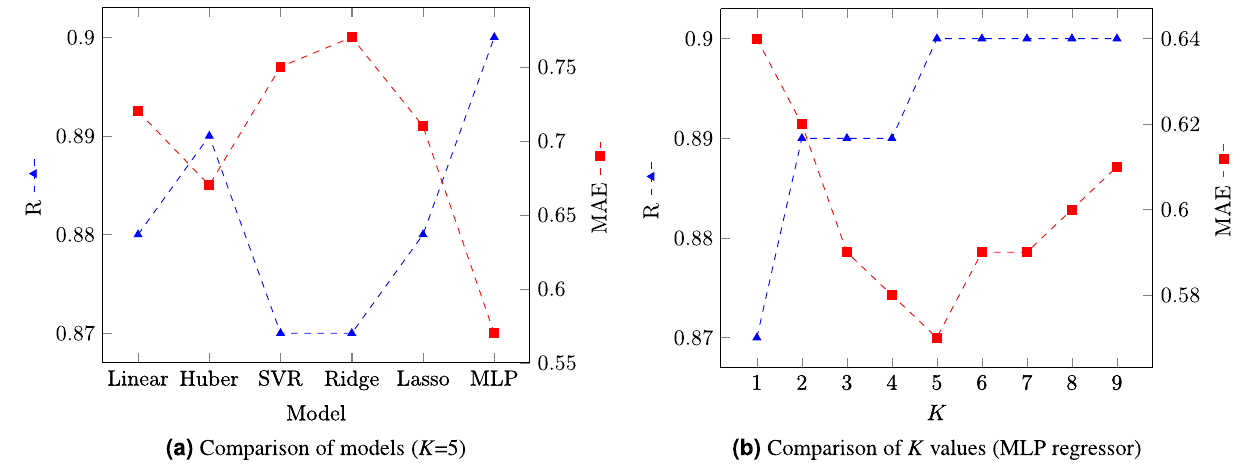
Figure 7. Pearson correlation (R) and mean absolute error (MAE) of the various regression models tested. In ( a ), six regression models including Linear Regressor, Huber Regressor, Support Vector Regressor, Ridge Regressor, Lasso Regressor, and Multi Layer Perceptron (MLP) are compared when K = 5 . MLP yielded the best results: R (0.9) and MAE (0.57). In ( b ), the effect of K versions of the MLP model, representing the number of required normalizations per image to calculate the mean value for each feature, is shown. MAE reduction is also maximized at K = 5 , after which diminishing returns were